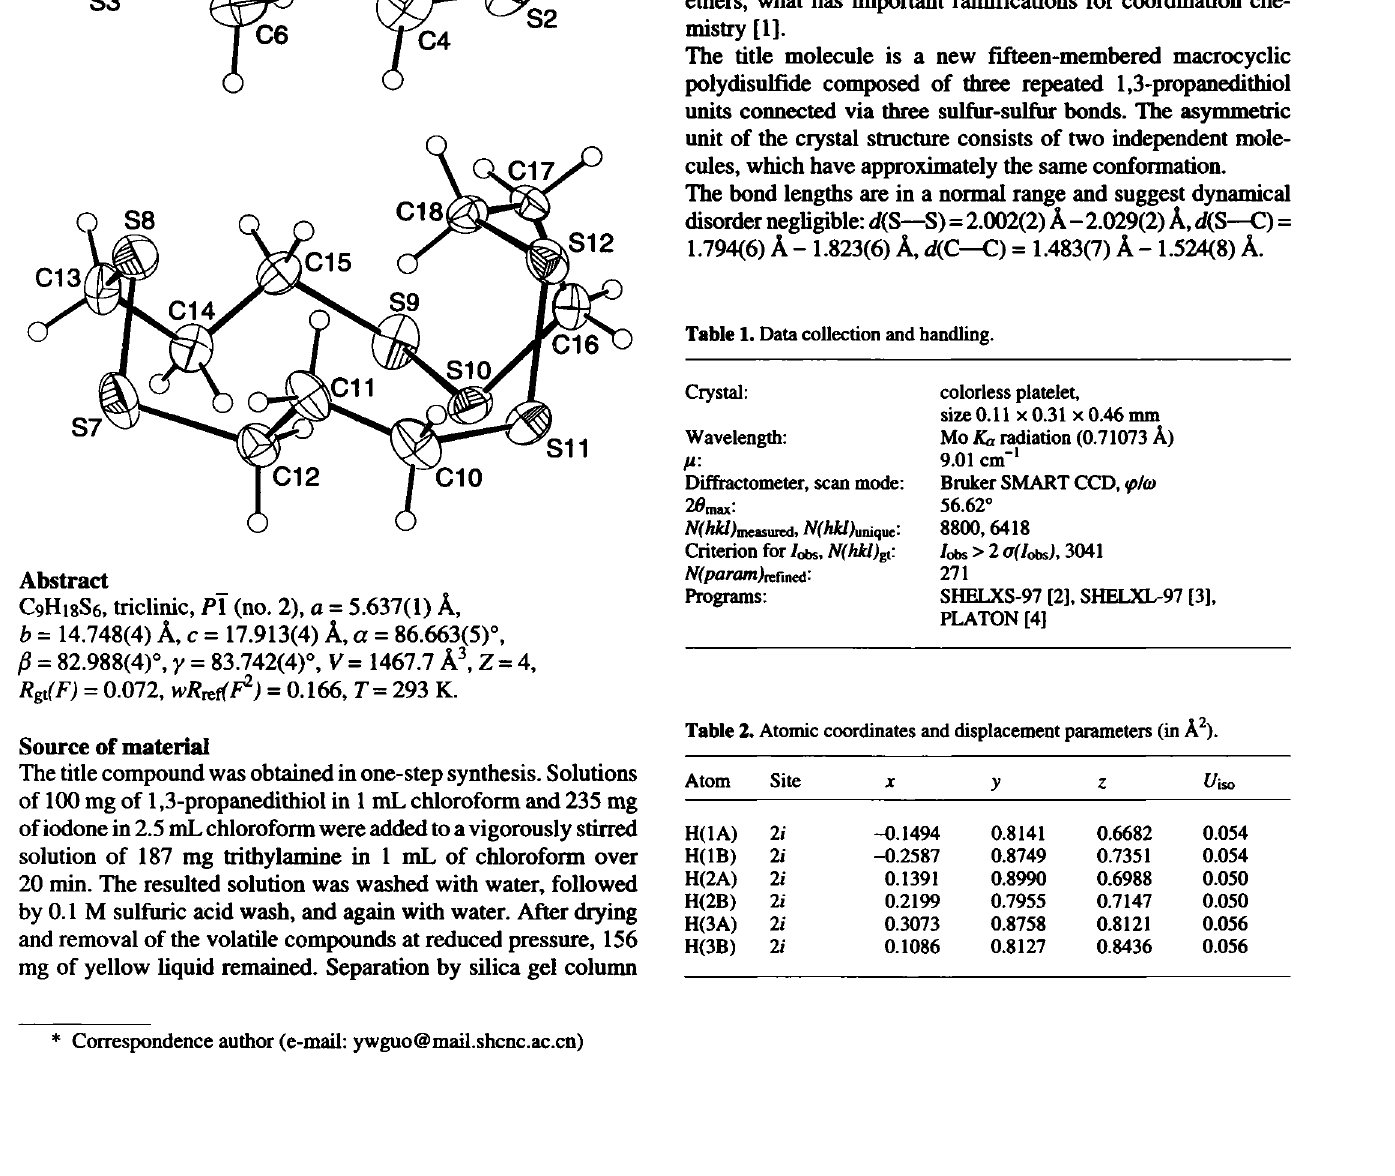
Table 1. Data collection and handling.